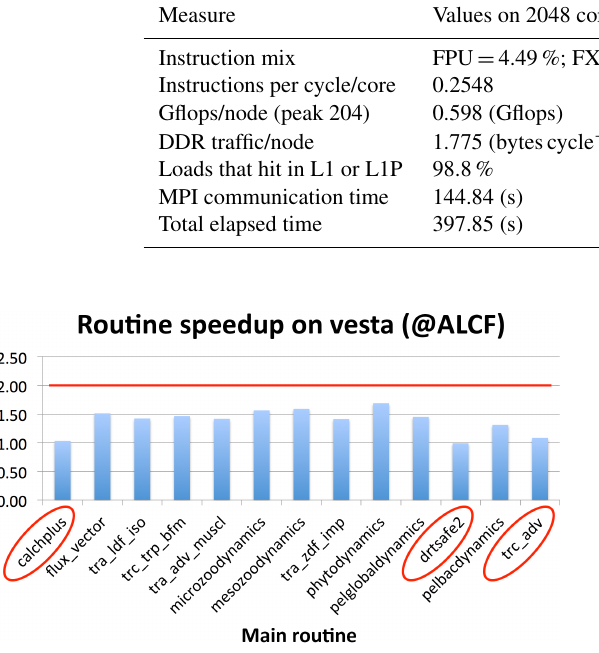
Figure 6. Analysis of scalability of the main routines on the BG/Q cluster in terms of speedup. The speedup is evaluated as the ratio be- tween the execution time on 2048 and 4096 cores. Hence the ideal scalability is reached with speedup equal to 2. The red circles indi- cate the routines whose speedup is far from the ideal